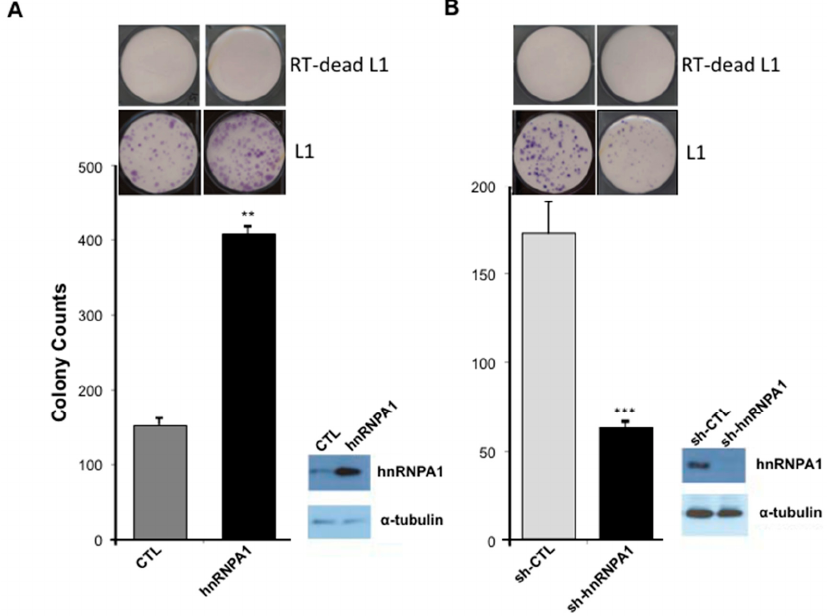
Figure 4. Overexpression of hnRNPA1 enhances de novo L1 retro-transposition and hnRNPA1 knock-down reduces L1 mobilization. ( A ) De novo retro-transposition was determined by a colony formation assay in HeLa cells stably transduced with plasmids encoding control plasmid (control), hnRNPA1 and transfected with L1 expression construct. Western blot analysis validating reduced levels of hnRNPA1 in over-expressing cell lines are shown. α -tubulin was used as a loading control (right panel). ( n = 3 technical replicates, mean ± SD, ** p < 0.01). ( B ) Representative example of neomycin-resistant colony counts from a colony formation assay in HeLa cells stably transduced with plasmids encoding shRNA against GFP (Green Fluorescent Protein) (control), hnRNPA1 and transfected with WT L1 (L1) or RT deficient L1 (RT-dead L1) expression construct. ( n = 3 technical replicates, mean ± SD, *** p < 0.001). Western blot analyses of hnRNPA1 and α -tubulin in knock-down HeLa cell lines are shown (right panels).